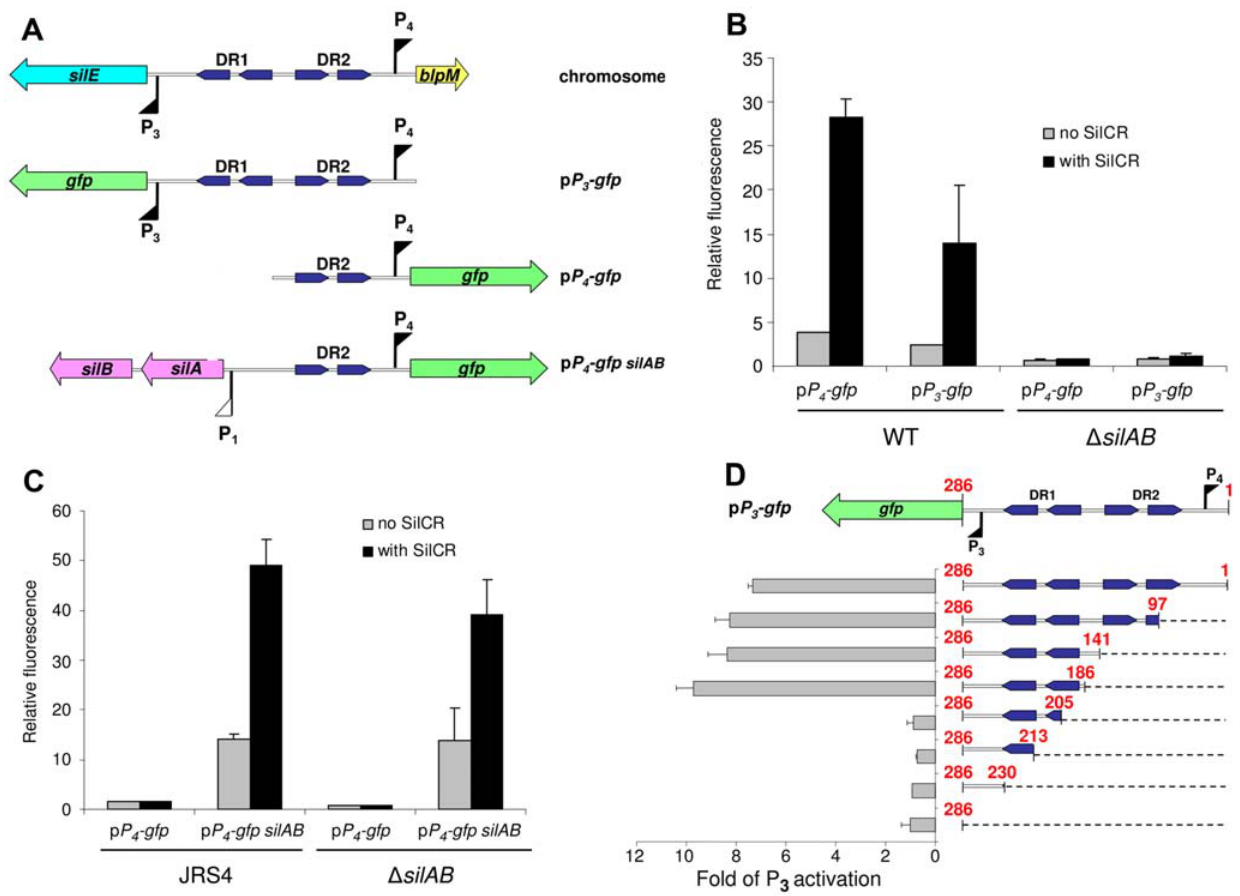
Figure 2. Identification of DNA motifs which serve as putative binding sites of SilA. (A) A schematic representation of the silE-blpM intergenic region, and the construction of reporter plasmids. The p P 3 -gfp and p P 4 -gfp plasmids were constructed by fusing P 3 and P 4 promoters, together with the entire intergenic region or part of it, to a promoterless gfp reporter. The p P 4 -gfp silAB plasmid consists of the original p P 4 -gfp with the addition of a DNA segment encoding the TCS SilA-SilB and its native promoter. Blue arrows indicate Direct Repeats (DR). Colored big arrows indicate genes and flags stand for SilCR-induced (filled flag) or non-induced (empty flag) promoters. (B) The activation of the P 3 and P 4 promoters by SilCR is absolutely dependent on the TCS SilA-SilB. JS95 WT and its derived mutant D silAB harboring either the p P 4 -gfp or the p P 3 -gfp plasmids were grown to an OD 600 =0.3 in the presence or absence of 10 m g ml 2 1 of SilCR. The fluorescence of the PBS-washed bacteria was measured by a fluorometer and normalized to the optical density. (C) The expression of the TCS SilA-SilB is necessary for transcription activation of P 4 in a D silAB mutant and sufficient for activation of P 4 in the sil -deficient M6-type GAS strain, JRS4. Relative fluorescence of the JRS4 and JS95-derived D silAB mutant harboring, either the p P 4 -gfp or p P 4 -gfp silAB plasmid, was determined as in (B). (D) Delineation of the minimal DNA segment required for P 3 activation. A set of plasmids harboring different lengths of the silE-blpM intergenic region (right-hand side) was generated by progressively and unidirectionally digesting the DNA segment from P 4 to P 3 (see ‘‘Materials and Methods’’). The fluorescence of JS95 strains harboring these plasmids was determined as in (B). The results are expressed as a fold of P 3 activation calculated for each strain by dividing the normalized fluorescence values obtained upon their growth in the presence and absence of SilCR. The values shown in panels B, C and D represent the mean 6 the standard deviations of at least two independent experiments.